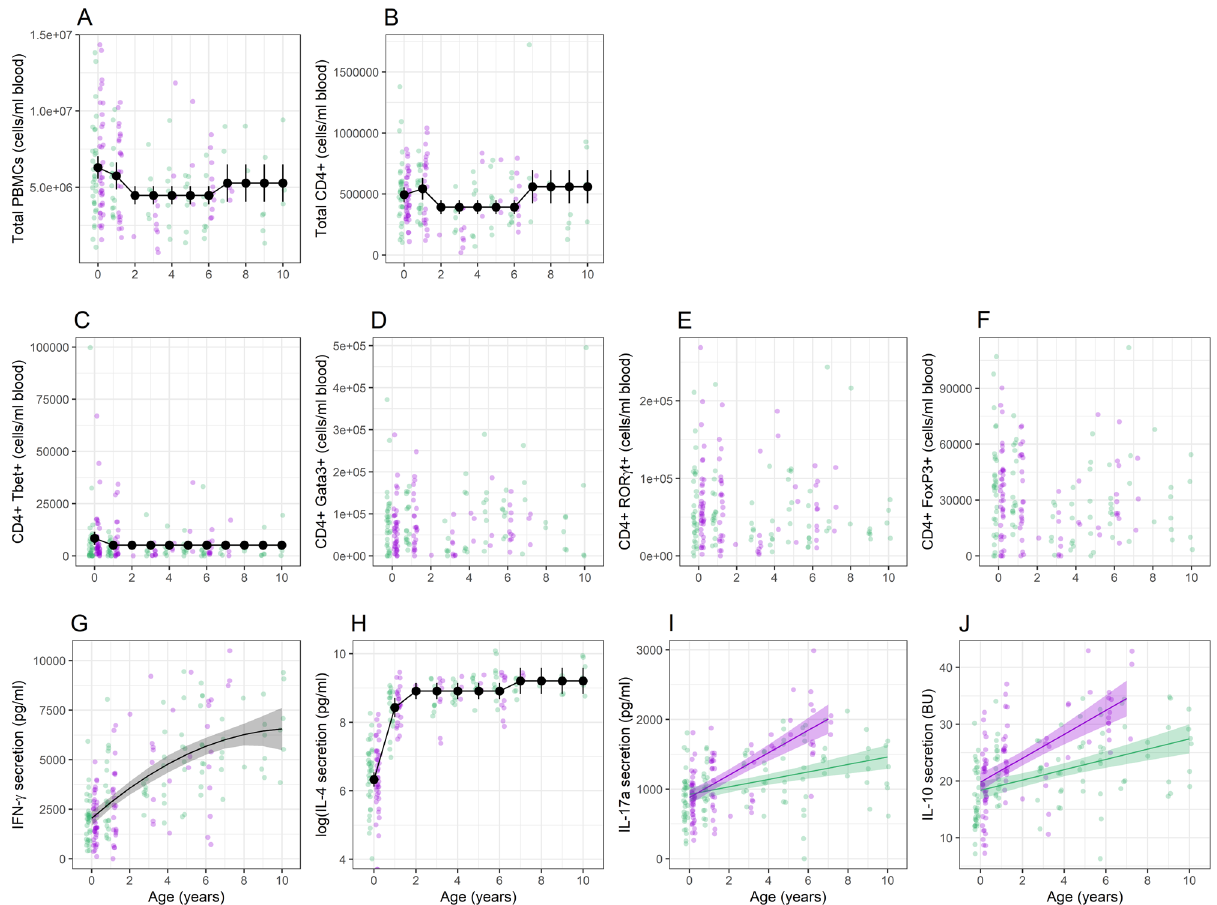
Figure 3. Age- and/or sex-specific variation in ( A ) PMBC; ( B ) CD4 + cells; ( C ) CD4 + Tbet + cells; ( D ) CD4 + Gata3 + cells; ( E ) CD4 + RORγt + cells; ( F ) CD4 + FoxP3 + cells; ( G ) IFN-γ; ( H ) IL-4; ( I ) IL-17A; and ( J ) IL-10. Points show raw data, with green representing females and purple showing males. Large points connected by lines show estimates ± 95% CI from a model where age was fitted as a factor (with 2 or 4 levels) and lines with shaded areas show estimates ± 95% CI from models where age was fitted as a continuous variable; green lines represent females and purple lines males. For model details, see Supplementary Tables S4 and around age four, followed by a shallower increase thereafter (Fig. 3G). IL-4 followed a similar pattern, although the best-supported model had age as a factor with four levels: while IL-4 was low in lambs, it increased dramati- cally in yearlings, with subsequently smaller increases in adults and then geriatrics (Fig. 3H). The best-supported models for both IL-17A and IL-10 suggested an interaction between age and sex, with linear increases with age in both sexes, but a particularly pronounced increase in males compared to females (Fig. 3I,J). As predicted, models of strongyle FEC identified negative associations with Th2-related immune meas- ures while models of coccidian FOC identified negative associations with Th1-related measures (Table 1). In separate models testing the association between FEC and each immune measure, we found that the number of CD4 + Gata3 + cells (estimate = − 2.69E−06 ± 1.07E−06, χ 2 1 = 5.42, P = 0.020) and the expression of IL-4 (esti- mate = − 9.84E−05 ± 2.26E−05, χ 2 1 = 16.97, P < 0.001; Table 1) each negatively predicted FEC. We also found significant interactions between age (lamb versus older) and total PBMC, CD4 + RORγt + and CD4 + FoxP3 + cell counts (Table 1). In each case, there was a stronger negative association with FEC in lambs, and little evidence of an association in adults. We then fitted all of these terms into a single GLM of FEC to determine which were independently significant. Only the main effects of CD4 + Gata3 + (estimate = − 3.24E−06 ± 1.21E−06, χ 2 1 = 4.77, P = 0.029; Supplementary Table S6) and IL-4 (estimate = − 8.97E−05 ± 2.27E−05, χ 2 1 = 13.81, P < 0.001; Sup- plementary Table S6), and the interaction between age and CD4 + FoxP3 + were still supported in this model (Supplementary Table S6). Inclusion of coccidian FOC in this final model did not meaningfully alter these results, and FOC did not significantly predict FEC independent of age, sex and the including immune param- eters (Supplementary Table S6). Both the number of CD4 + Gata3 + cells and levels of IL-4 were independently negatively associated with FEC, while the interaction between age class and CD4 + FoxP3 + suggested a nega- tive association in lambs but not adults (Fig. 4A–C). In separate models testing the association between FOC and each immune measure, both IFN-γ and IL-4 were negatively associated with FEC (Table 1). However, when we fitted both of these into the same model, IFN-γ was still supported (estimate = − 1.26E−04 ± 4.94E−05, χ 2 = 6.03, P = 0.014, Fig. 4D) but IL-4 was not (estimate = 1.03E−05 ± 3.16E−05, χ 2 = 0.12, P = 0.727). Inclusion of